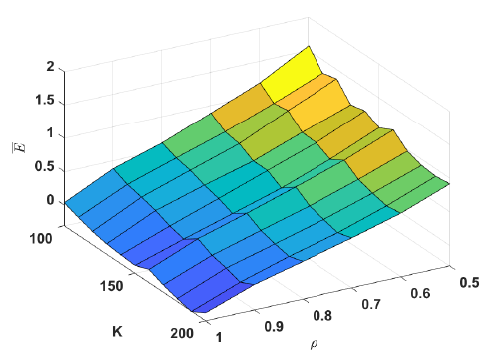
Figure 6. Average expansion E with different values of K and ρ